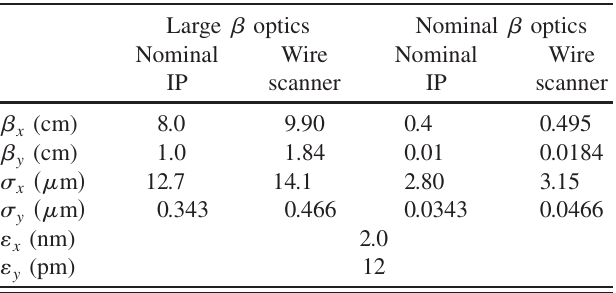
TABLE I. Beam parameters with nominal and large (cid:1) optics. Large (cid:1)